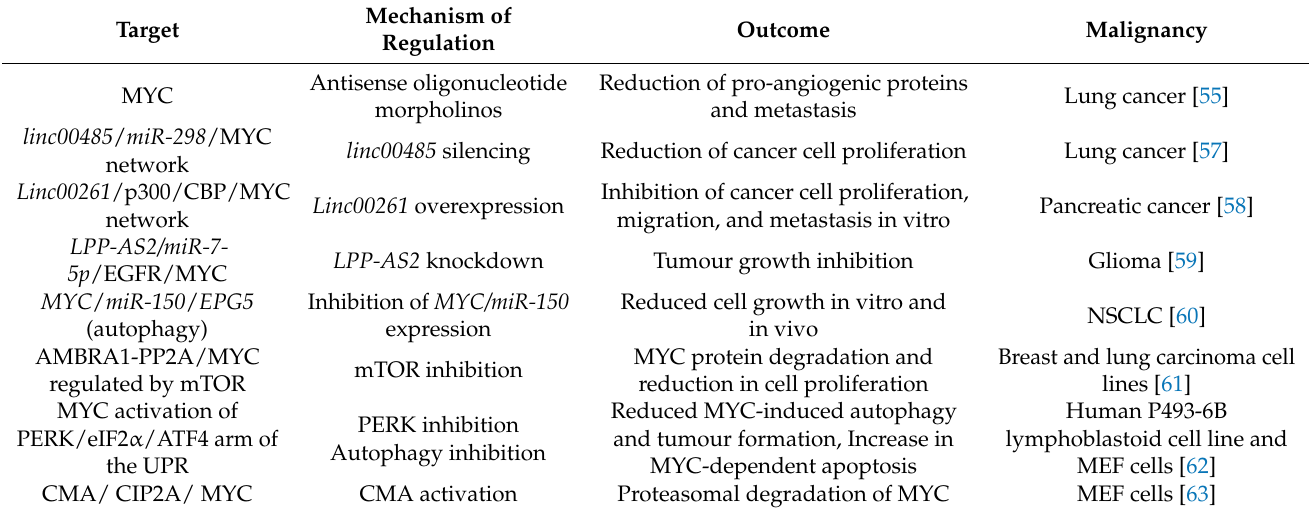
Table 2. Strategies to modulate MYC-driven gene networks concerning regulatory, lncRNAs, and autophagy-related processes and